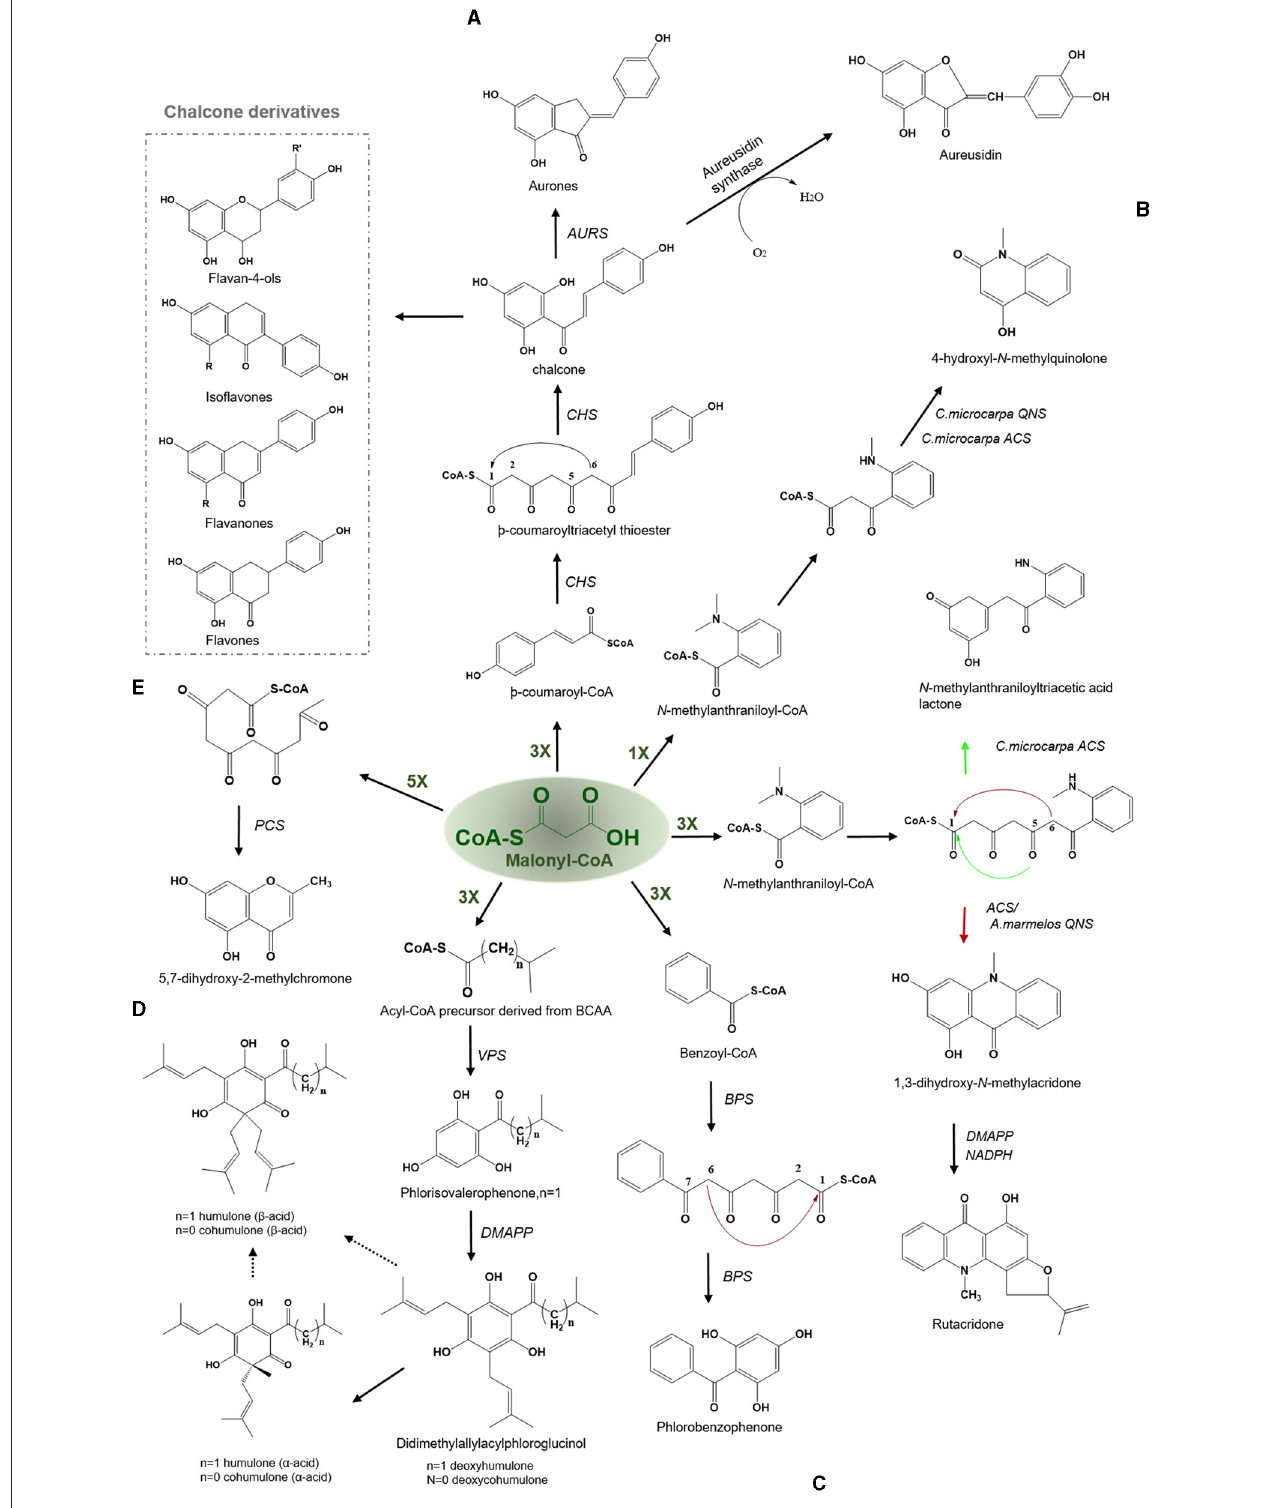
FIGURE 3 | Examples of Claisen type condensation reactions employed by various type III PKSs to produce a variety of polyketide products. Describes the reaction catalyzed by (A) chalcone synthase (CHS) and Aureusidin synthase, (B) acridone synthase (ACS), (C) benzophenone synthase (BPS), (D) valerophenone synthase (VPS), and (E) pentaketide chromone synthase (PCS). The dashed arrows represent the proposed pathways. The green-colored nX value represents the number of malonyl-CoA molecules employed in a reaction; DMAPP, dimethylallylpyrophosphate; BCAA, branched-chain amino acid.